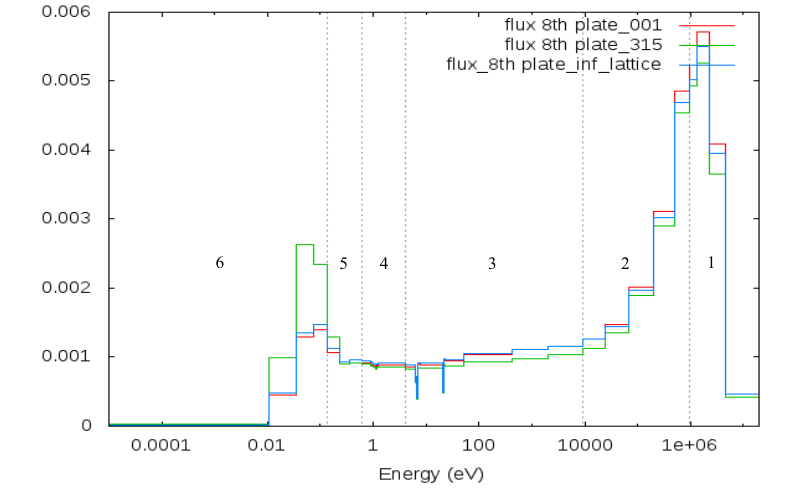
Figure 8. Flux in the eighth fuel plate